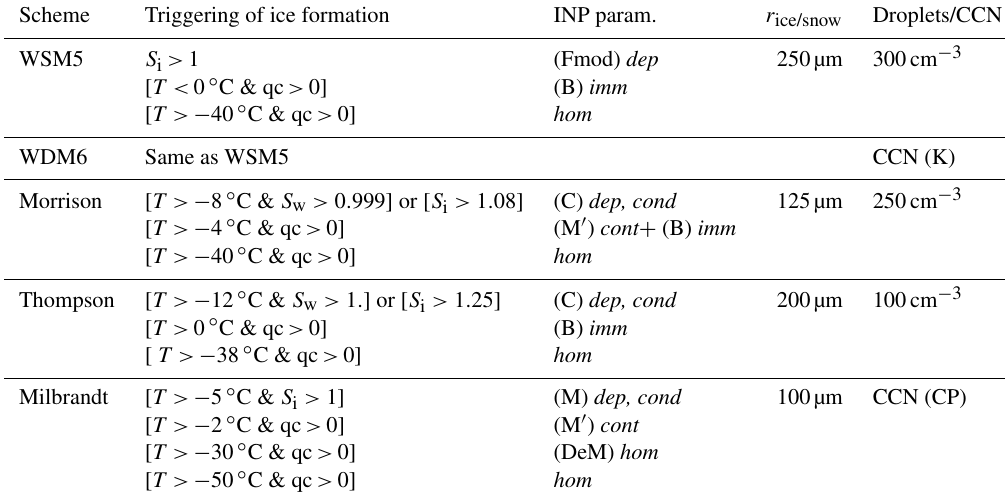
Table 3. Characteristics of the ice phase and liquid phase activation for the microphysics schemes. T refers to the atmospheric temperature, and qc to the liquid water content. S i ( S w ) is the saturation ratio with respect to ice (liquid water). r ice/snow indicate the cut-off size for icy particles considered either as ice crystals (smaller particles) or snow (larger particles). INP parameterizations (INP param.) account for the various freezing processes presented in Sect. 1: imm is immersion freezing; dep is deposition freezing; cont is contact freezing: cond is condensation freezing; and hom is homogeneous freezing (considered as instantaneous, i.e. straight conversion of liquid to ice). IN/freezing parameterizations’ references: (Fmod) is a modified version of Fletcher (1962) presented in Hong et al. (2004); (C) is Cooper (1986); (M) is Meyers et al. (1992) Eq. (2.4); (M (cid:48) ) is Meyers et al. (1992) Eq. (2.6); (B) is Bigg (1953) for probabilistic freezing; (DeM) is Demott et al. (1994) for probabilistic freezing. CCN activation parameterizations: (K) is Khairoutdinov and Kogan (2000); (CP) is Cohard and